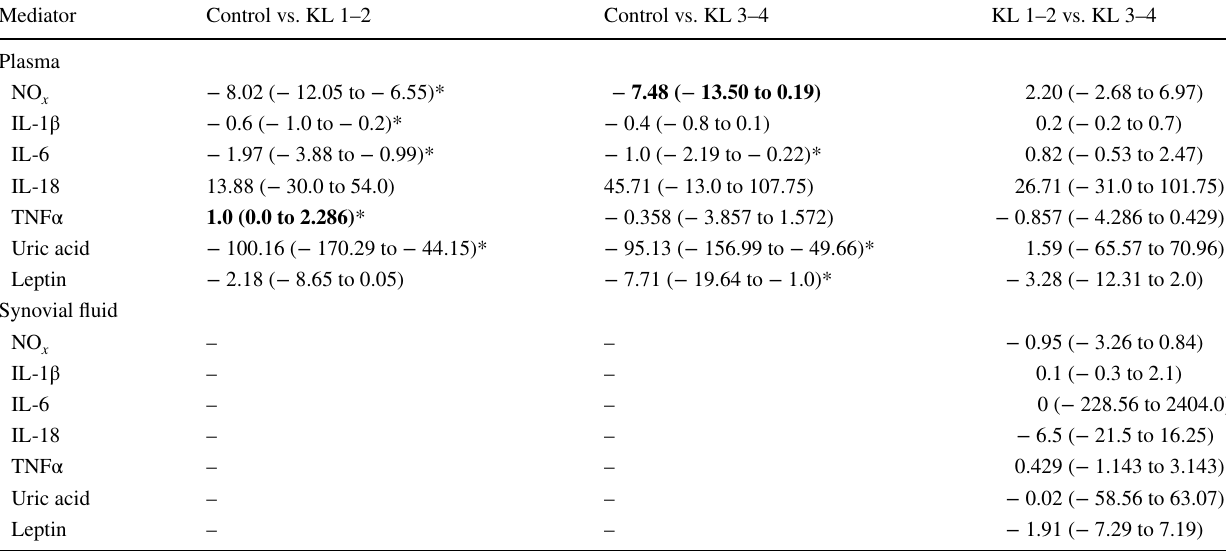
Table 3 Hodges–Lehmann estimates for the confidence intervals for the median differences between the groups